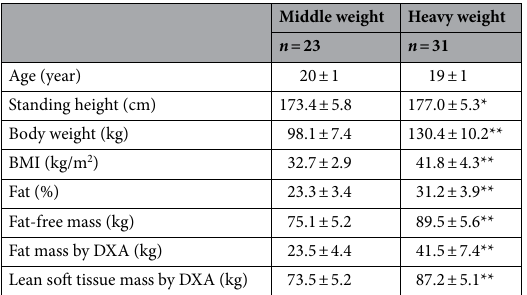
Table 1. Subject characteristics. Middle weight vs. Heavy weight: * p < 0.05, ** p <